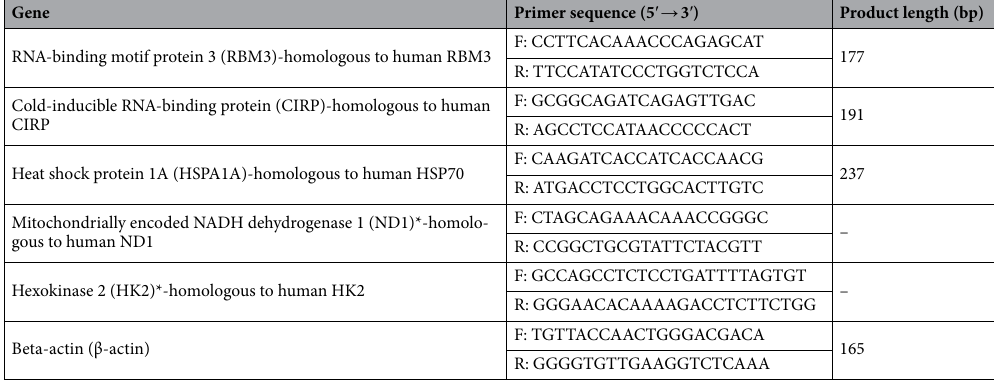
Table 1. Primer sequences used in real-time PCR. *Cited from Quiros et al. 26 .